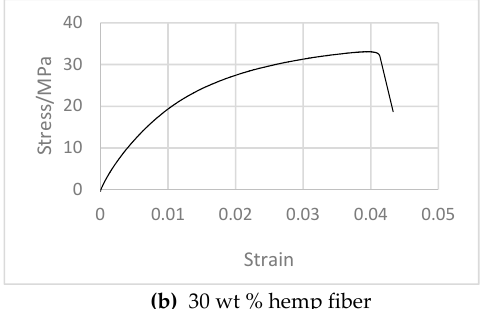
Figure 13. Typical stress versus strain graphs for ( a ) PP-only and ( b ) 30 wt % hemp fiber filament. Table 1. Failure strain of fiber reinforced filaments.